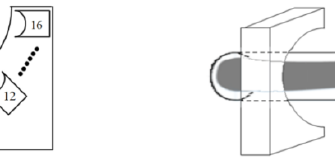
( e ) Figure 5. Carbon fiber sucker rod: ( a ) small crack defect, ( b ) transverse crack defect, ( c ) hole defect, ( d ) chapped defect, and ( e ) with no defect. The ultrasonic pulse-echo signal uses the abscissa to represent the time-of-flight, and the ordinate to represent the amplitude of the pulse-echo signal. Therefore, the internal information of the material to be measured can be judged by the number and position of reflected echoes. Each pulse peak of the pulse-echo signal represents the reflected echoes from the interface between two materials with a significant difference of acoustic imped- ance. When a single probe detects the intact carbon fiber rod, the ultrasonic reflection sig- nal is obtained, as shown in Figure 6. When the ultrasonic wave emitted by the probe enters the carbon fiber rod, it generates the 1# reflected echo at its front surface; when the ultrasonic wave passes through the front interface of the carbon fiber rod, it generates the 2# reflected echo due to the change in impedance; when the ultrasonic wave passes through the rear interface of the carbon fiber rod, it generates the 3# reflected echo; when the ultrasonic wave propagates to the rear surface of the carbon fiber rod, it generates the 4# reflected echo. As a result, for the intact carbon fiber rod, four reflected echoes corre- sponding to each interface of the carbon fiber rod are received.